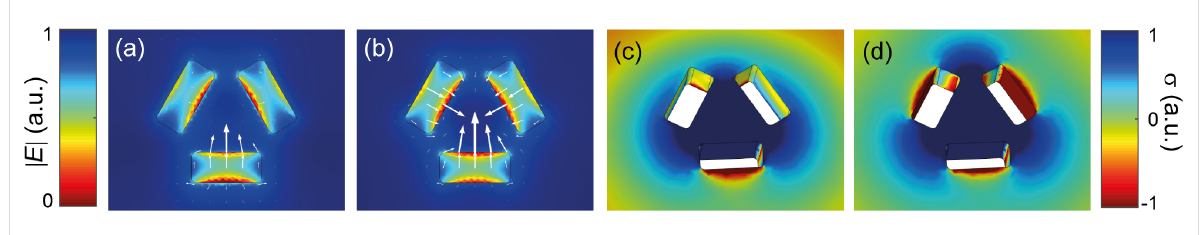
Figure 7: Electric field inside a trimer of rectangular slots of length 150 nm and width 65 nm separated by a distance of 100 nm in a gold film of thick- ness 100 nm excited by an electric dipole located 30 nm above a point on the film 5 nm inside the inner edge of the lower slot. The magnitude of the electric field (direction shown with arrows) in a plane a distance of 5 nm above the lower surface of the gold film at wavelengths of (a) 680 nm and (b) 800 nm. The (instantaneous) surface charge densities on the metal–dielectric boundary at wavelengths of (c) 600 nm and (d) 800 nm are also